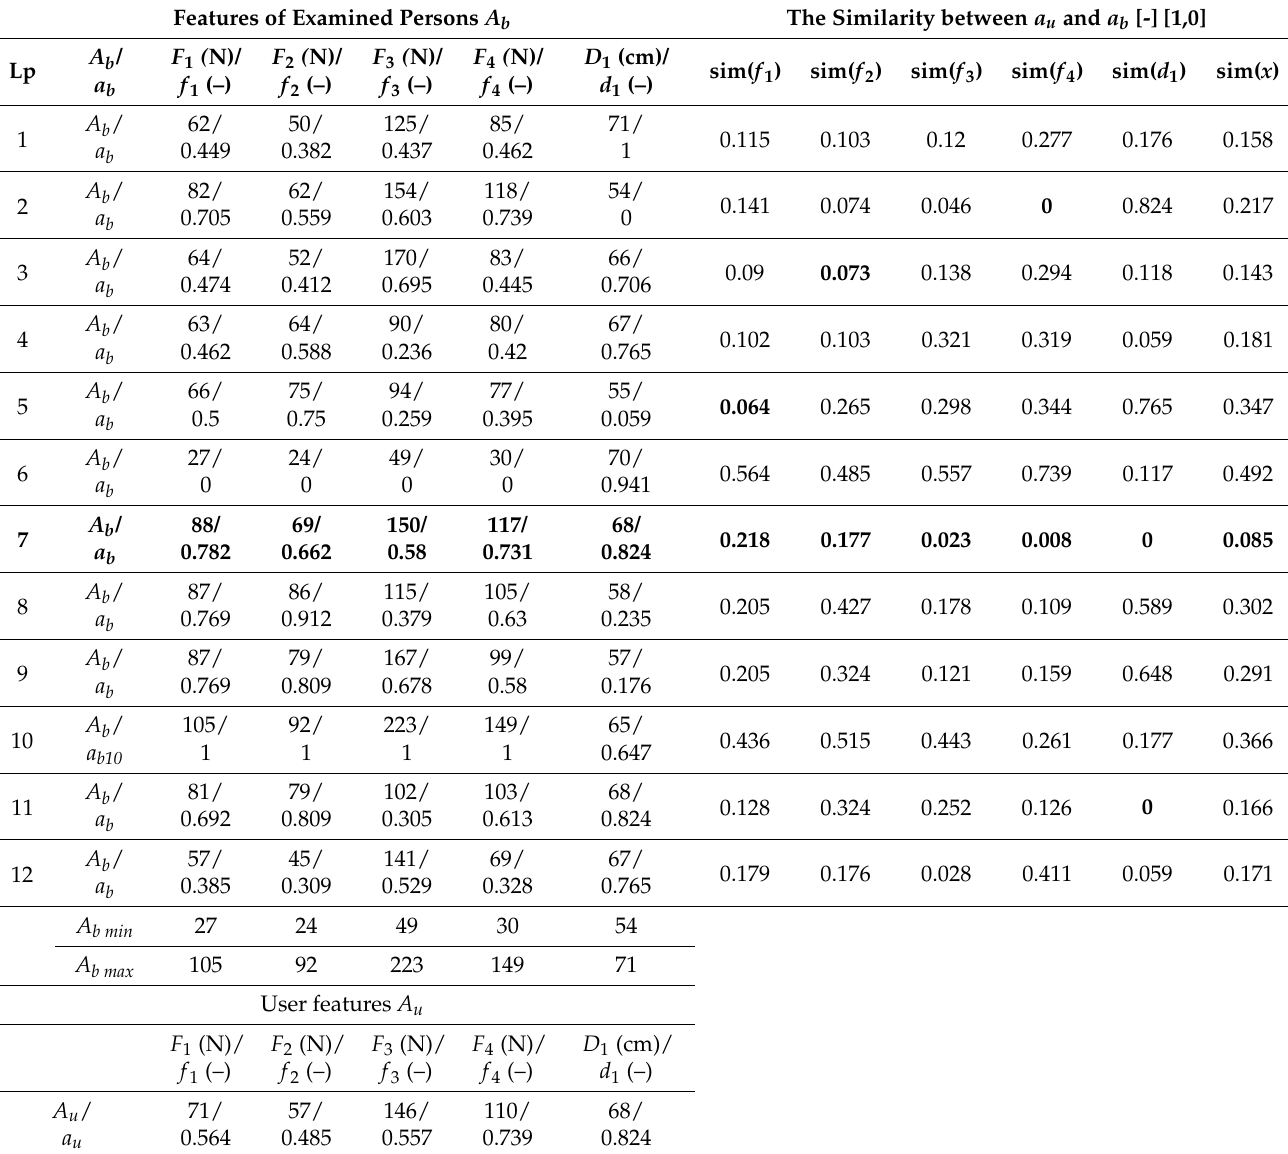
Table 1. Example of a worksheet to calculate the similarity between a simplified model of an individual convenient zone and a complete model from the